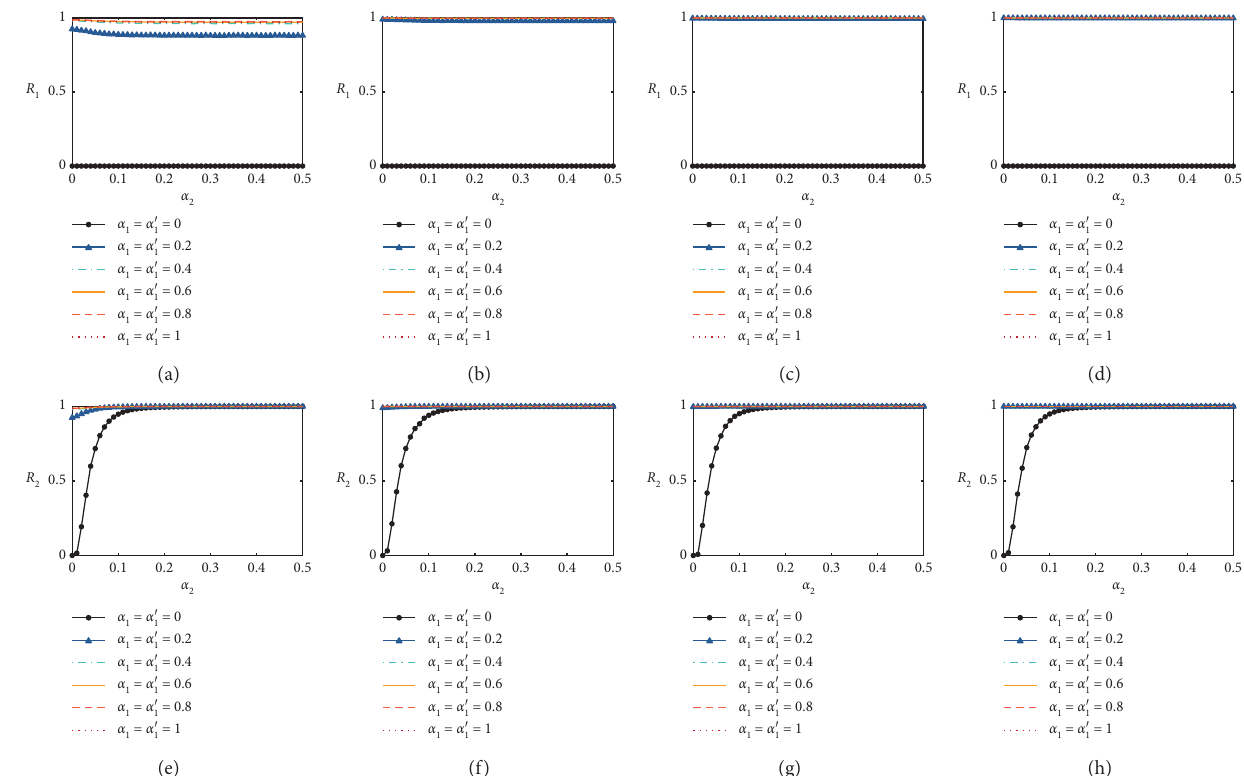
Figure 5: Virus spreading size R with (a) λ parameters are set to be c